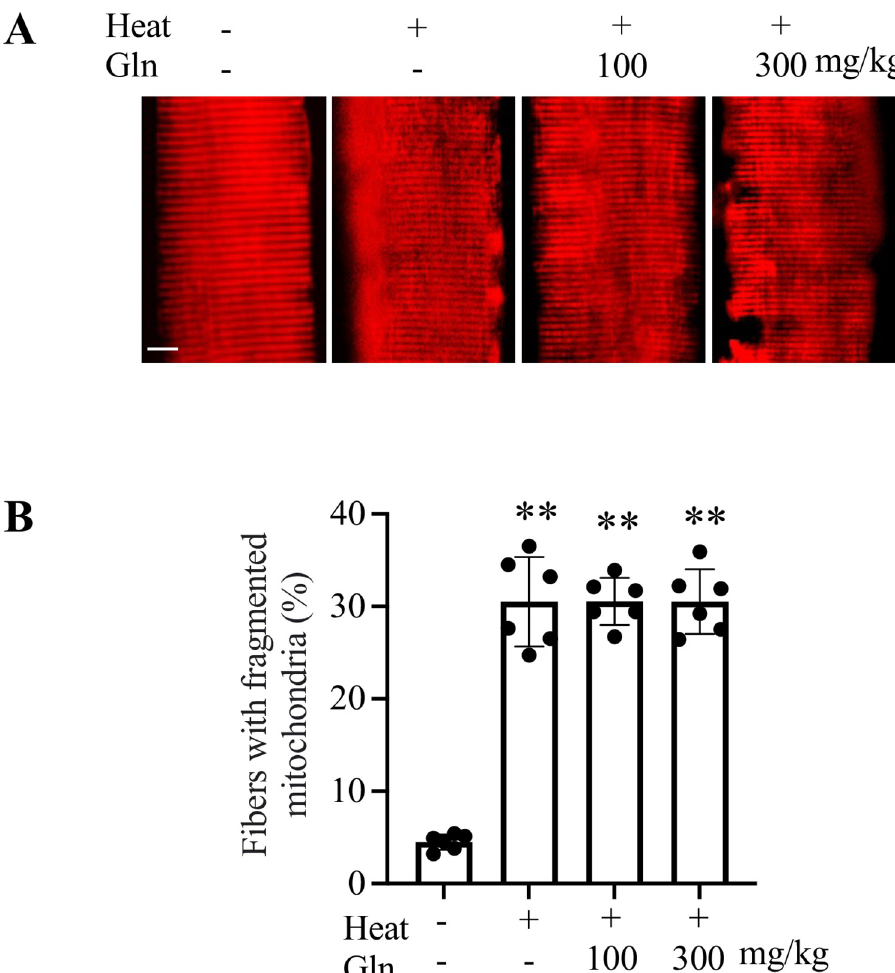
Fig 3. Mitochondrial morphology in flexor digitorum brevis muscle of sham and heat-exposed mice. A: Representative images show MitoTracker-stained myofibers from each group (scale bar: 10 μ m). B: Quantitative analysis of mitochondrial morphology was performed on randomly selected 20 myofibers per animal. Values are mean ± SD. �� p < 0.0001, n = 6 mice per group.